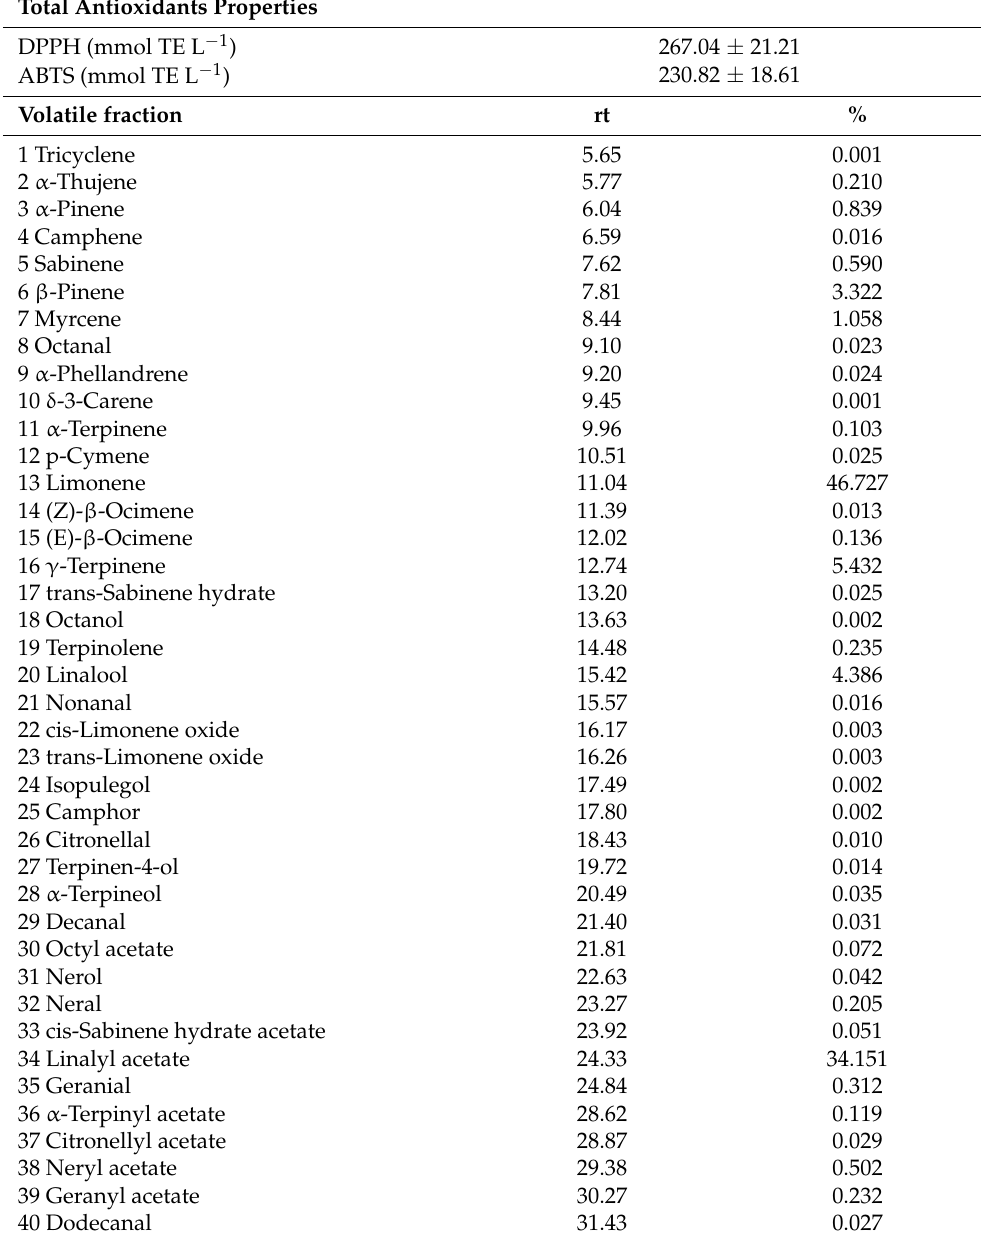
Table 3. Chemical composition of bergamot essential oil